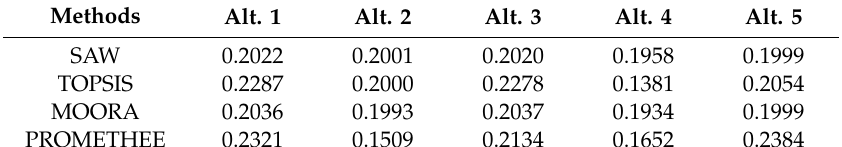
Table 3. Transformed MADM results applying classical normalization.